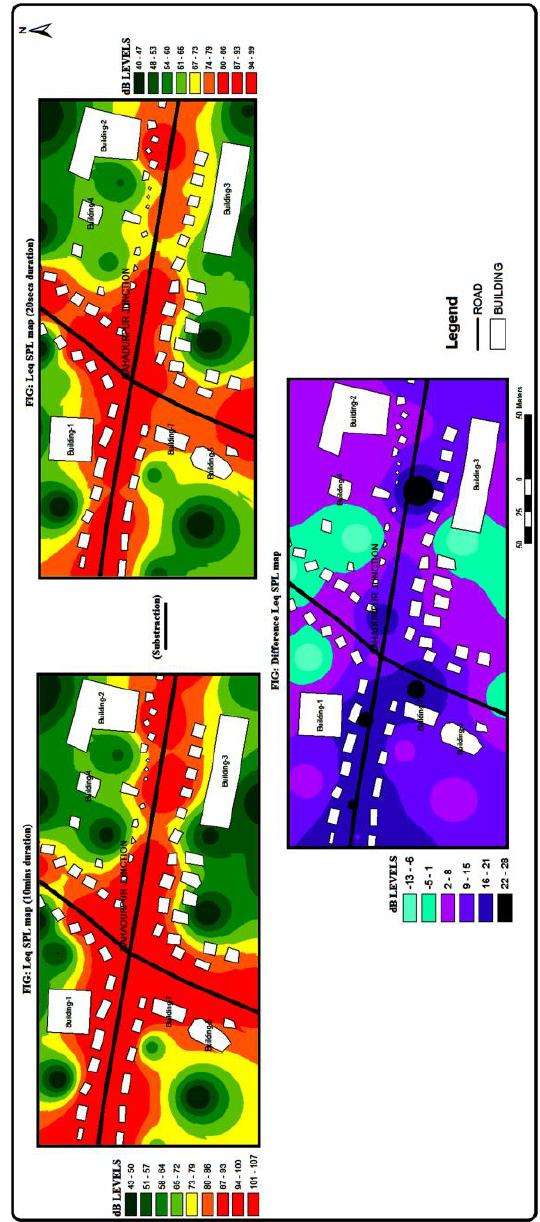
Figure 11. Average Noise Maps in Bahadurpur Crossing for Instantaneous and Short Time Duration and their Difference 5-6